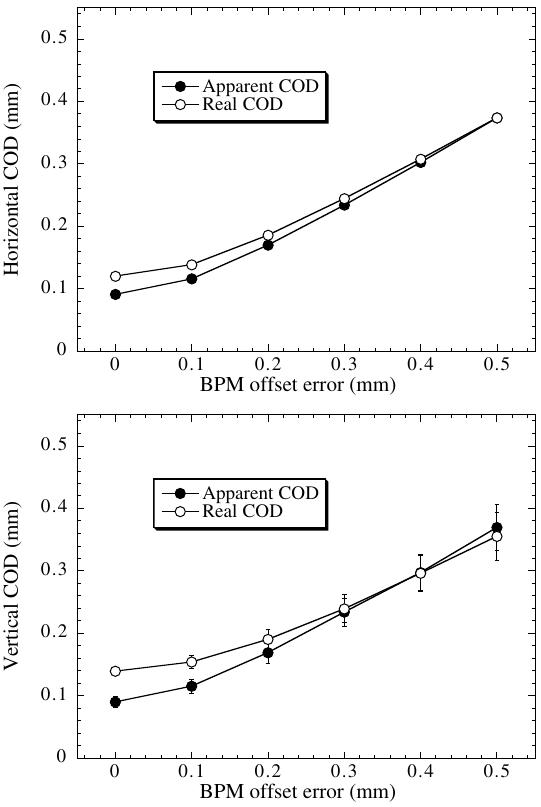
FIG. 13. Averages of rms of the (top panel) horizontal and FIG. 12. Averages of (top panel) (cid:3) and (cid:3) , (bottom arc ; meas arc (bottom panel) vertical COD vs (cid:27) and C vs (cid:27) after the coupling correction. The panel) C xy meas xy (cid:16) tion. The error bars indicate the standard error bars indicate the standard deviations.